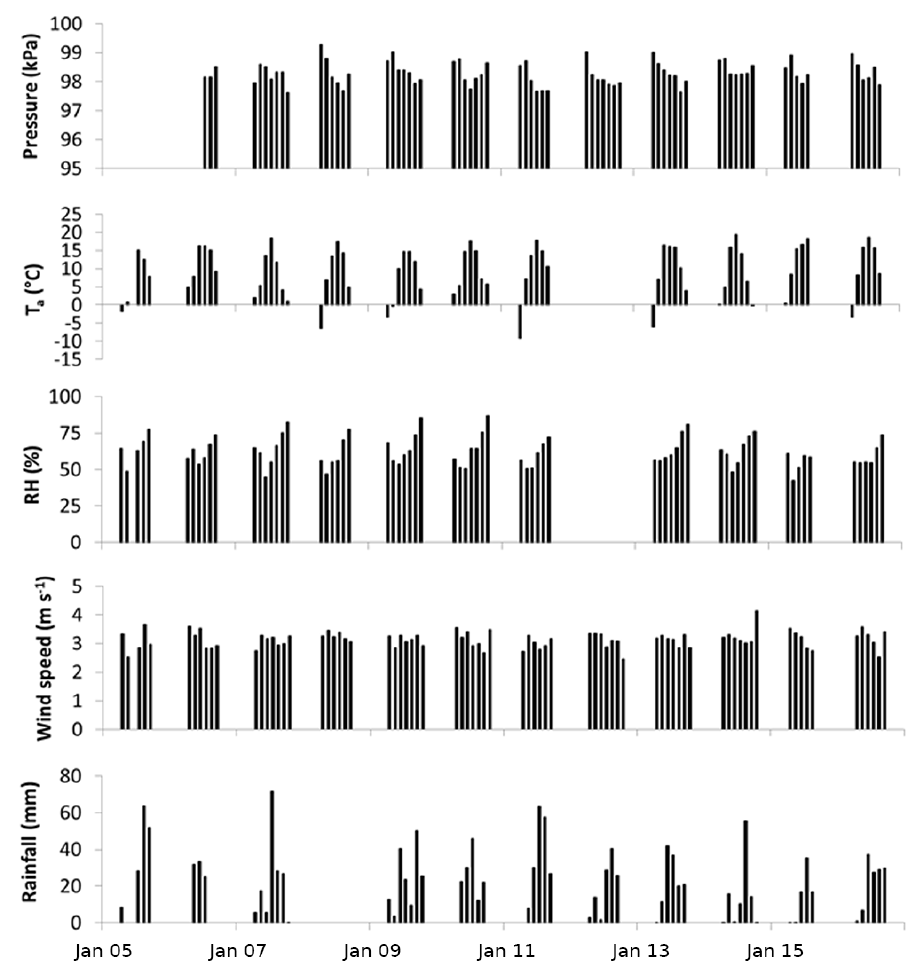
Figure 7. Monthly average meteorological conditions at the bedrock ridge climate tower in 2005–2016. T a refers to air temperature, RH denotes relative humidity, and pressure refers to barometric